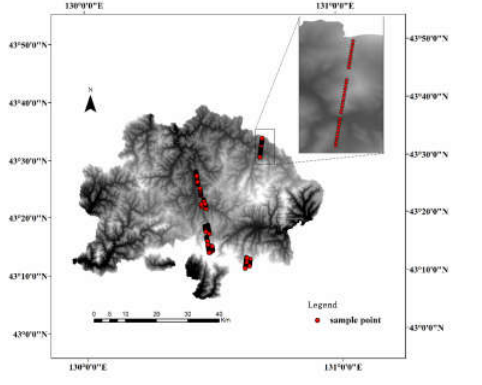
Figure 1. Study area and the location of sample